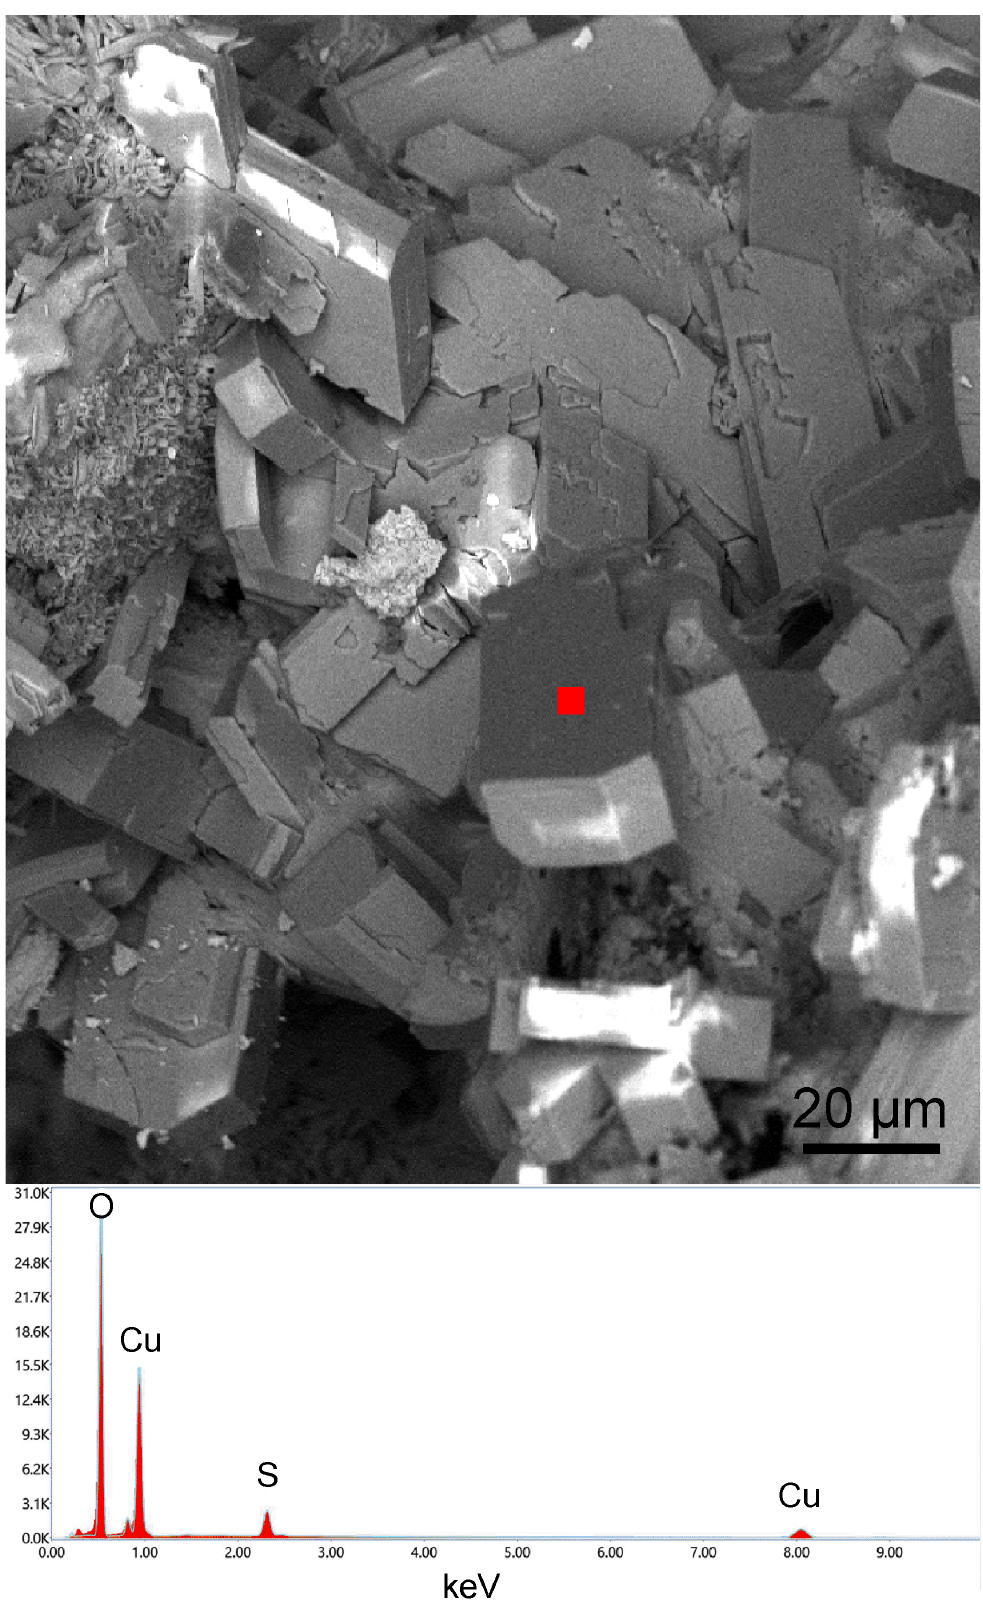
Figure 12. SEM image and corresponding EDS spot analysis (red filled square) of monoclinic langite crystals from the Mastricarro Barite Mine (Catanzaro, southern Italy).